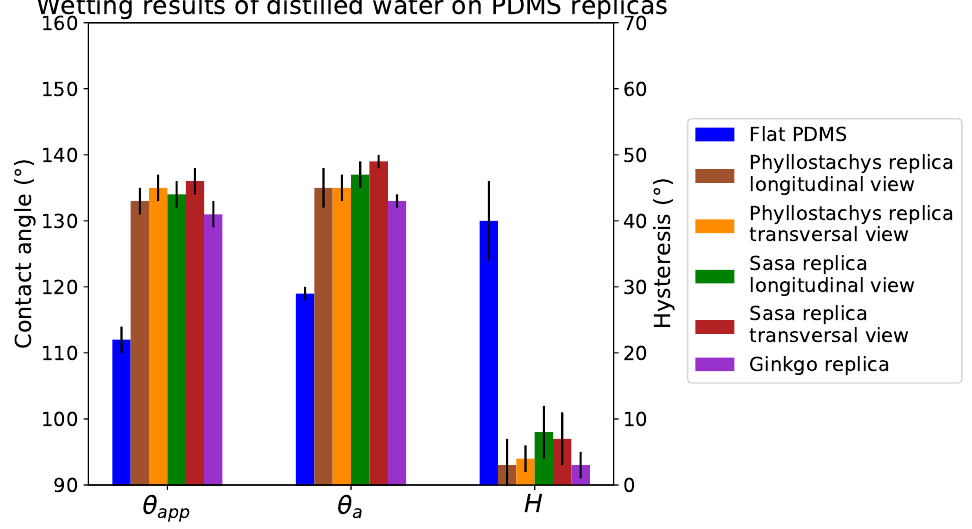
Figure 10. Wetting results on flat PDMS and replicas.